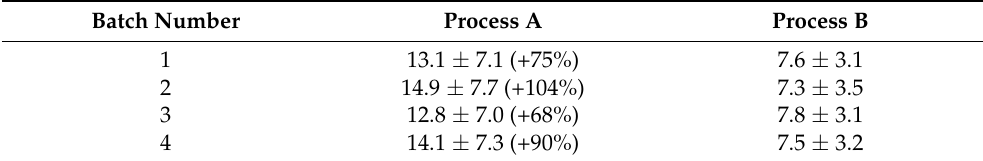
Table 7. Length of fibre bundles (cm) inside all the produced final